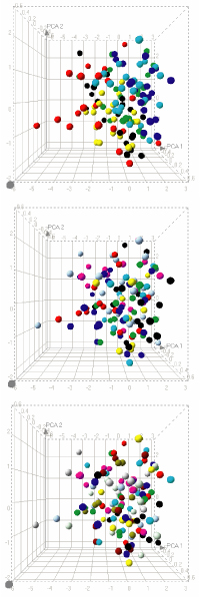
Assessment of systematic variability across plates, chips, and spots using principal component analysis (PCA) on the 144 quality control samples used in the liver cancer and liver toxicity study. The 144 spectra obtained from assays of quality control samples from the liver cancer and liver toxicity study were first normalized. The five peaks which appeared in all 144 spectra were taken as the common proteins and used for PCA analysis using software Spotfire DecisionSite 7.1 (Somerville, MA, ). (A) The PCA results were color coded for the six Ciphergen bioprocessor plates used to assay the samples. The points represent the spectra and are spread randomly throughout the space. The spectra from each plate did not group together indicating a lack of systematic variability. (B) The PCA results were color coded for spot position. Each protein chip has eight spots. The spectra obtained from samples loaded on any same spot position can not be grouped together and randomly spread around in the PCA figure. Thus, spot position did not introduce systematic variability in the data. (C) The PCA results were color coded for the chip number in which each sample was loaded for SELDI analysis. Total 12 chips were used for one bioprocessor plate. The spectra of samples from any chips were not grouped together in the PCA, but rather were spread randomly in the space, indicating a lack of systematic variability due to the chip used to assay samples.